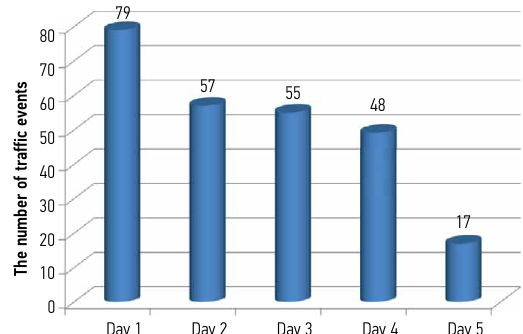
Fig. 2. The dependence of the number of traffic events on the number of the driver’s working days (after the rest days)